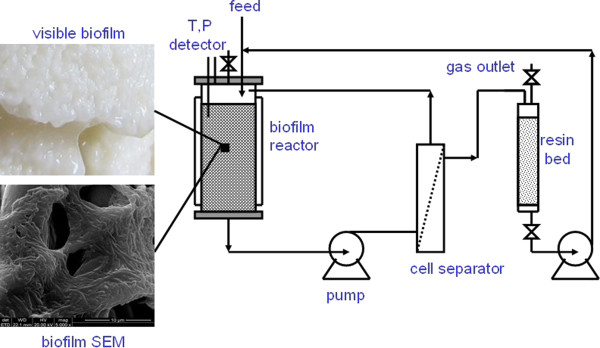
Schematic diagram of a biofilm reactor coupled to fixed-bed adsorption. The KA-I resin was packed in glass columns of 250-mm length and 30-mm diameter. Approximately 50 to 60 g of the resin was loaded in each column. After autoclaving, the resin column was connected to a 2-L biofilm reactor to construct an online product removal system. With feeding of concentrated P2 medium, fed-batch fermentation can be performed. Operation details are described in the Methods section. SEM, scanning electron microscopy; T, temperature; P, pressure.